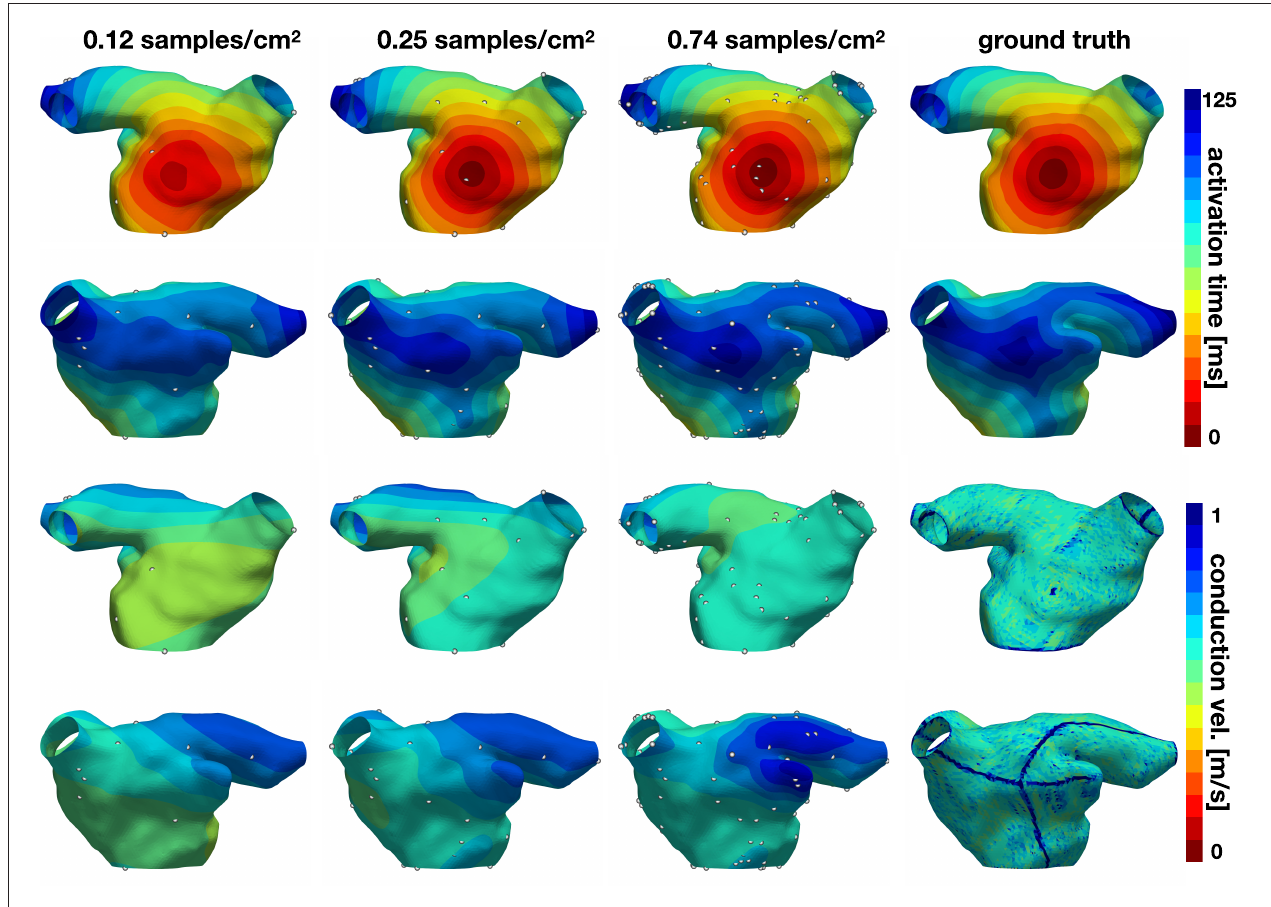
FIGURE 8 | Evolution of active learning for the homogeneous case with constant conductivity. The top two rows show the activation times for different sample densities and the ground truth for two different views. The bottom rows represent the conduction velocity.